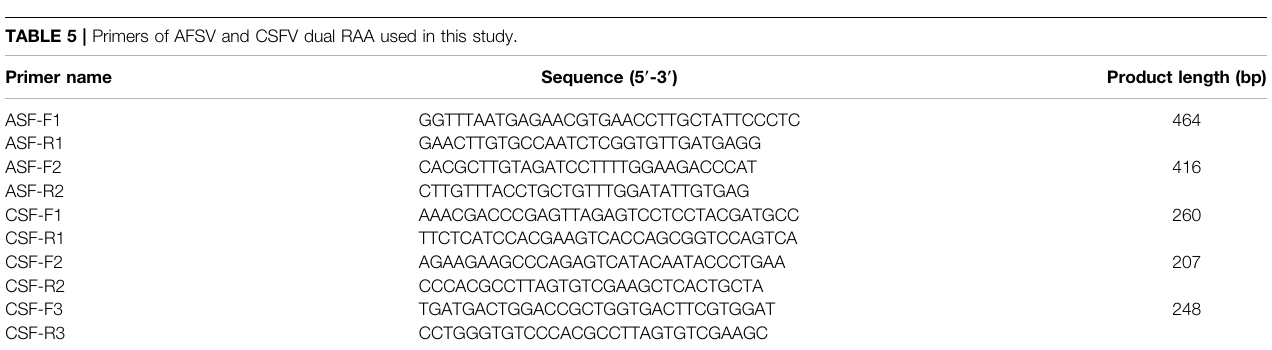
TABLE 5 | Primers of AFSV and CSFV dual RAA used in this